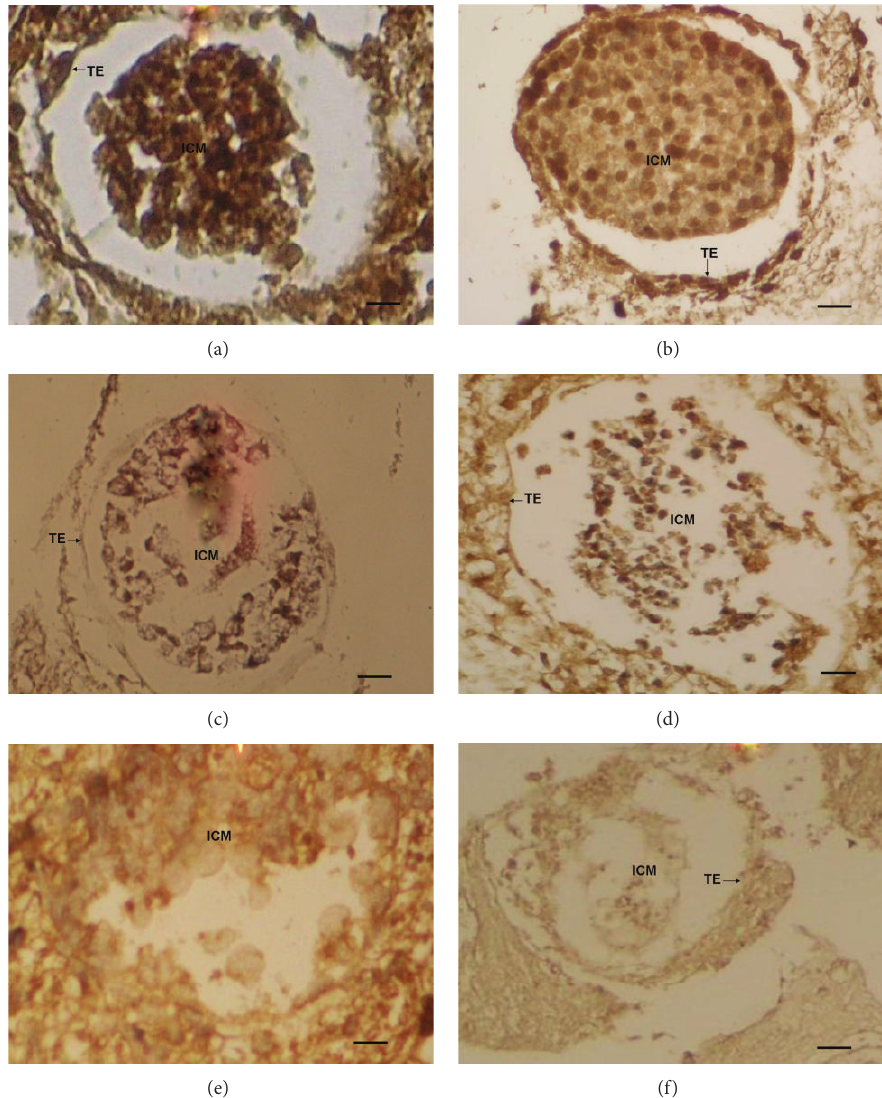
Figure 3: E-cadherin and Connexin 43 protein expressions. (a) Group 1, healthy male/healthy female, E-cadherin, magnification 20x ∗ ; (b) Group 2, healthy male/diabetic female, E-cadherin, magnification 100x ∗∗ ; (c) Group 3, diabetic male/healthy female, E-cadherin, magnification40x ∗∗∗ ;(d)Group4,diabeticmale/diabeticfemale,E-cadherin,magnification100x ∗∗ ;(e)Group1,healthymale/healthyfemale, Connexin 43, magnification 100x ∗∗ ; (f) Group 4, diabetic male/diabetic female, Connexin 43, (diabetic female/male, magnification 40x ∗∗∗ .